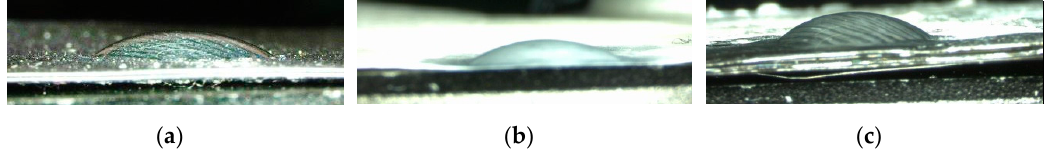
Figure 7. Contact angles, investigated by dropping 15 µl of distilled water on ( a ) an FDM-printed PLA layer, ( b ) an electrospun PAN nanofiber mat, and ( c ) a PAN/PLA composite prepared as described in this article.